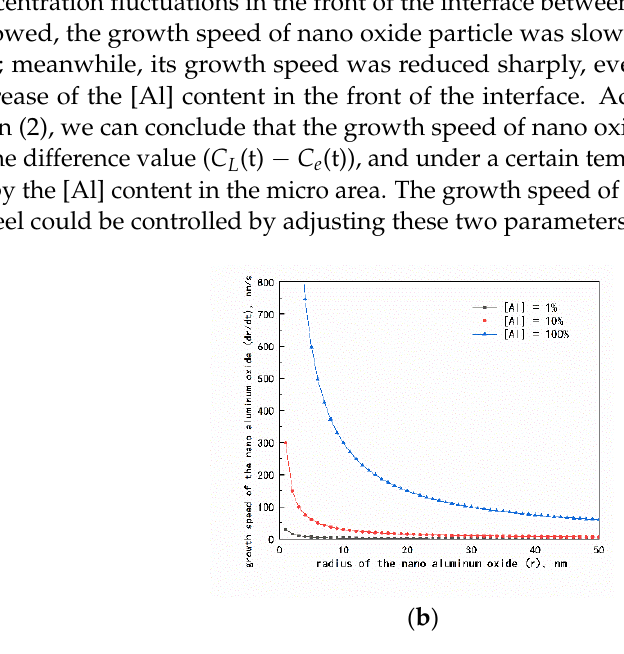
Figure 9. Radius of the nano aluminum oxide particle vs. growth speed under the condition of dif- ferent [Al] concentration at the temperature of 1873 K; ( a ) [Al] = 0.01%, 0.1% and 1%; ( b ) [Al] = 1% , 10% and 100%.